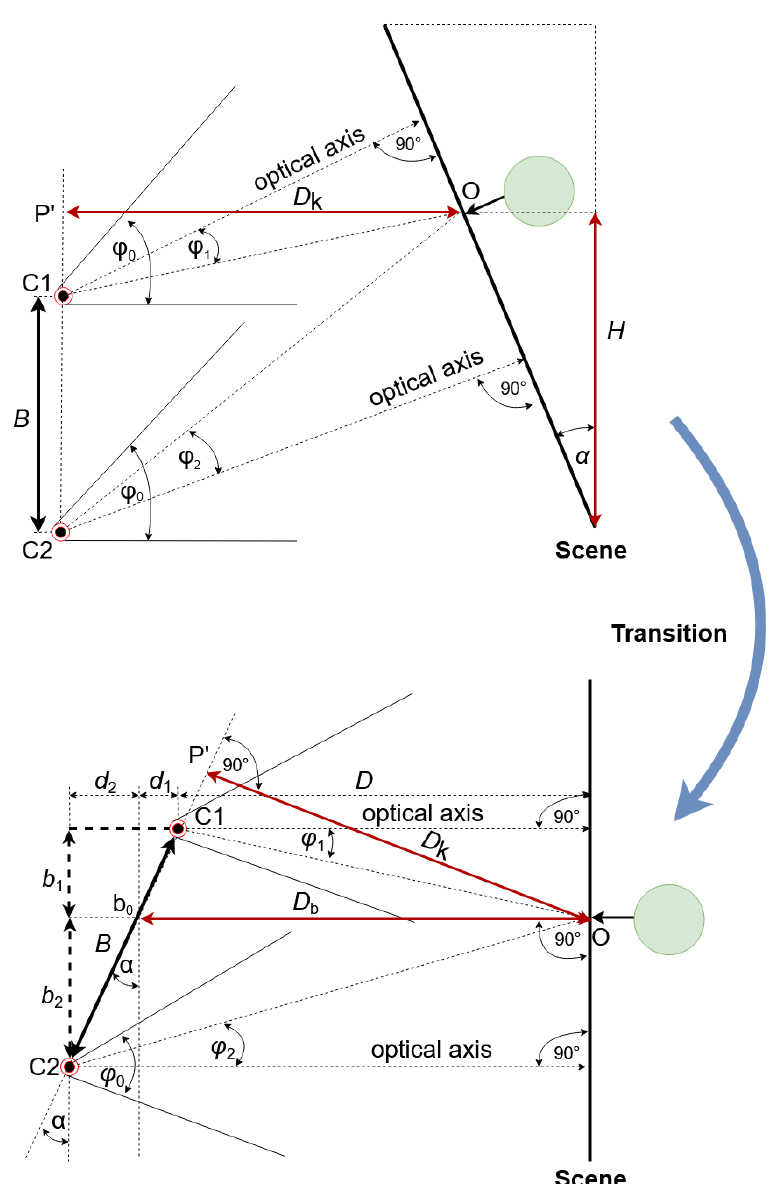
Figure 3. Definition of the variables and basic system